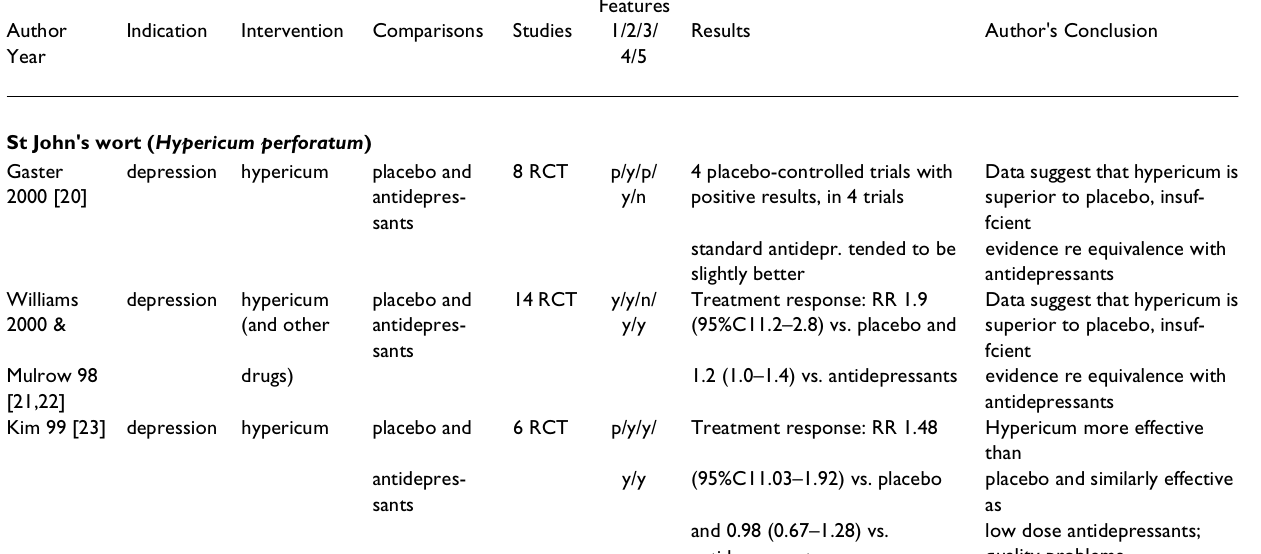
Table 2: Systematic reviews of clinical trials of hypericum and garlic preparations